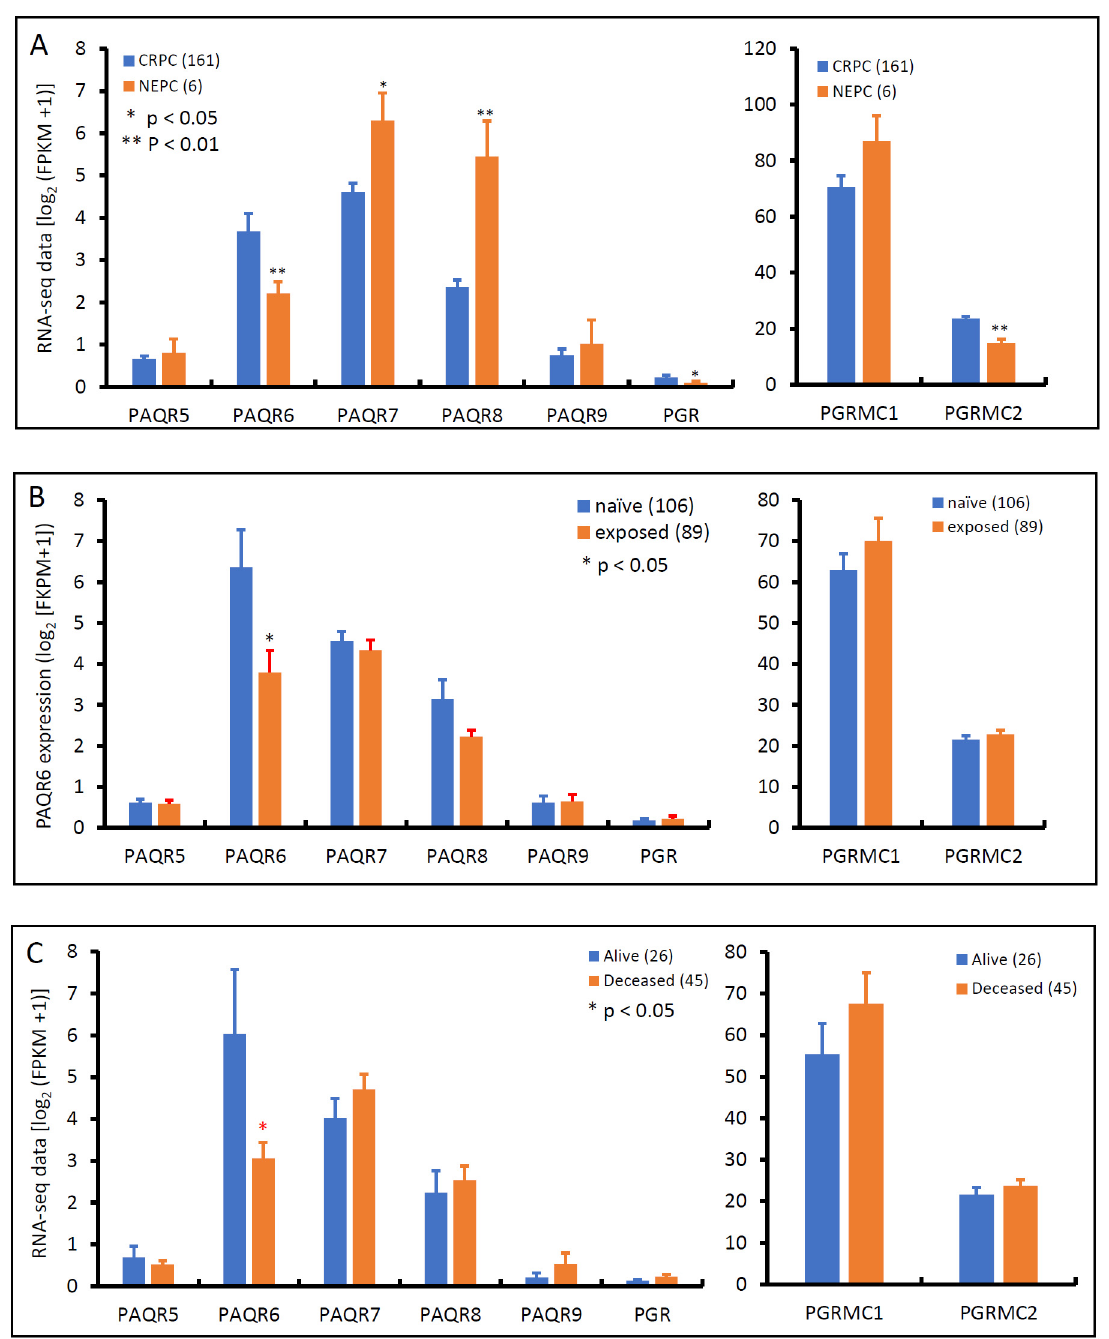
Figure 7. Alterations of PAQR gene expression in CRPC and NEPC tumors. Gene expression levels were compared between CRPC and NEPC tissues (panel A ), treated with or without AR antagonists (panel B ), or patients alive or deceased (panel C ) using the RNA-seq dataset generated from metastatic prostate cancer tissues [26]. Case numbers in each group were shown at the end of figure legends. The p -values were derived from the Student t -test in comparison to the CRPC, treatment naïve or alive group.